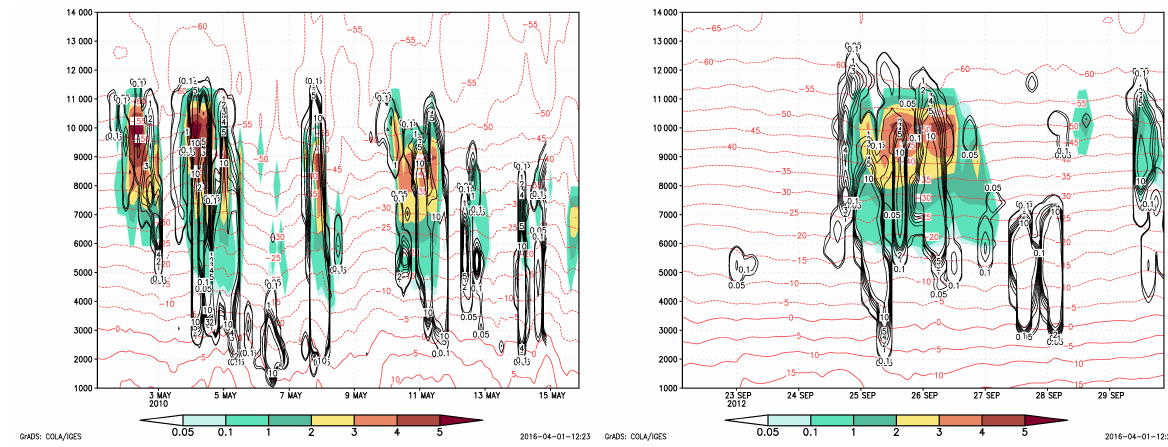
Figure 4. Comparison of log 10 (IWC × 10 − 6 kgm 3 ) obtained from the Doppler radar reflectivity using the Cloudnet algorithm (solid black line contour plot) vs. DREAM log 10 (n IN ) (coloured shaded plot) for the periods 1–15 May 2010 (left) and 22–30 September 2012 (right). Red contours show temperature as provided by the NMME